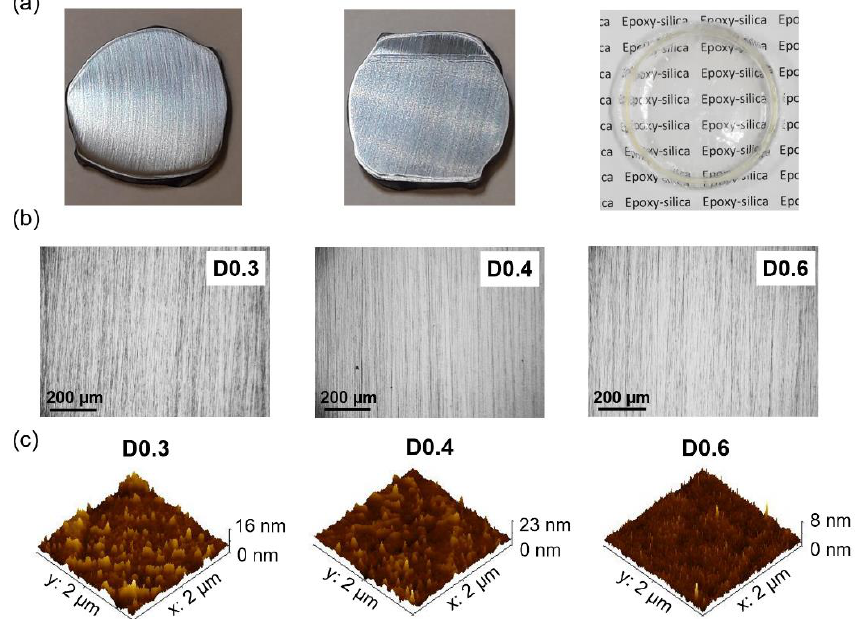
Figure 5. ( a ) Representative images of the uncoated reinforcing steel substrate ( left ), the epoxy-sil- ica-coated steel ( center ), and the freestanding hybrid ( right ); ( b ) Optical micrographs of the coatings deposited on the reinforcing steel substrate (the dots and scratch marks are characteristic of the polished substrate); and ( c ) 3D AFM topography images of the coatings prepared with different proportions of the curing agent.